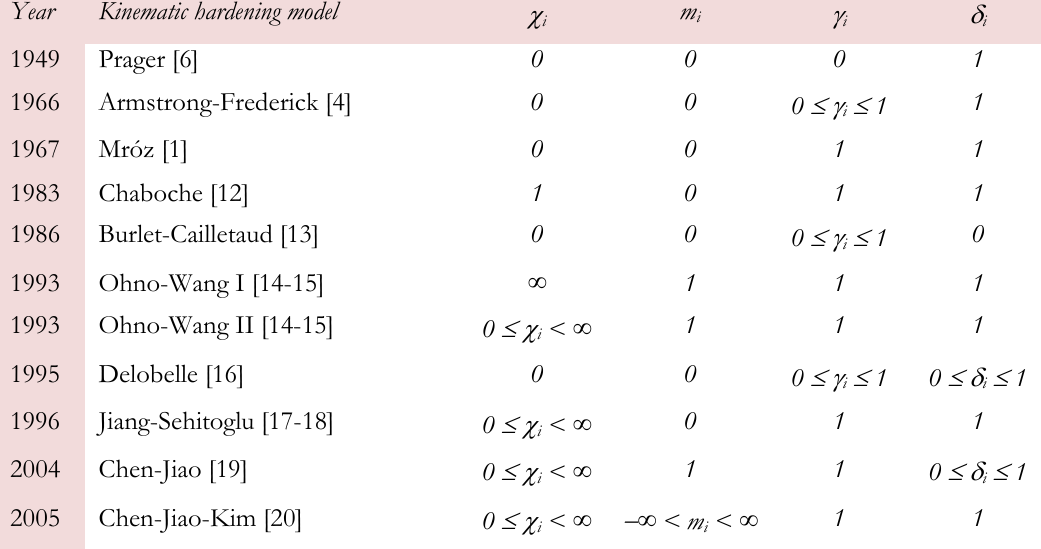
Table 1: Calibration parameters for the general translation direction from Eq.